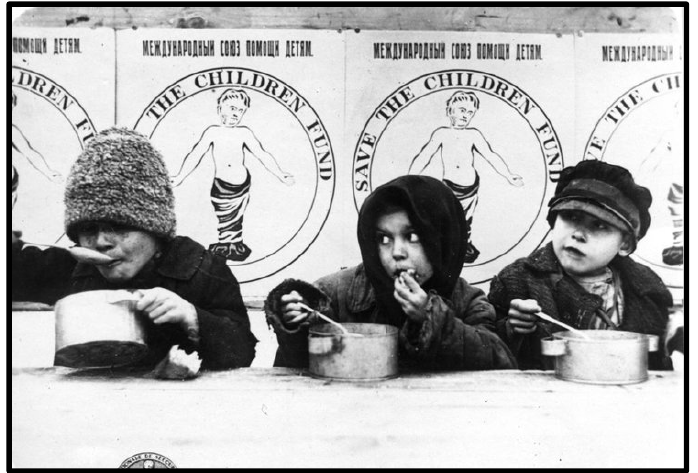
Figure 1. Famine in Russia, 1921–1923. Save the Children. All rights reserved.